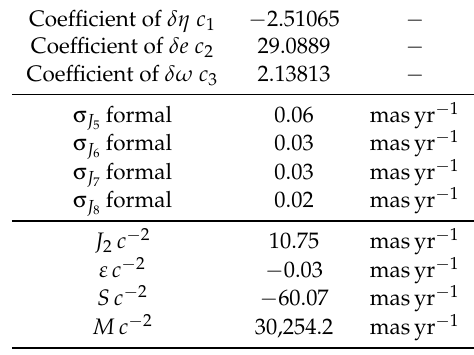
Table A4. Upper three rows: Numerical values of the coefficients c 1 , c 2 , c 3 of the linear combination of Equation (20) canceling out the classical precessions induced by the first three zonal harmonics J 2 , J 3 , J 4 for the orbital configuration of TableA2. Middle rows: Uncancelled mismodeled precessions due to the zonal harmonics J 5 , J 6 , J 7 , J 8 , in masyr − 1 , linearly combined according to Equation (20); the formal, statistical errors σ J in J (cid:96) , (cid:96) = 5, 6, 7, 8 of the model Tongji-Grace02s [48], quoted in TableA1 were (cid:96) used. Lower four rows: pN precessions, in masyr − 1 , linearly combined according to Equation